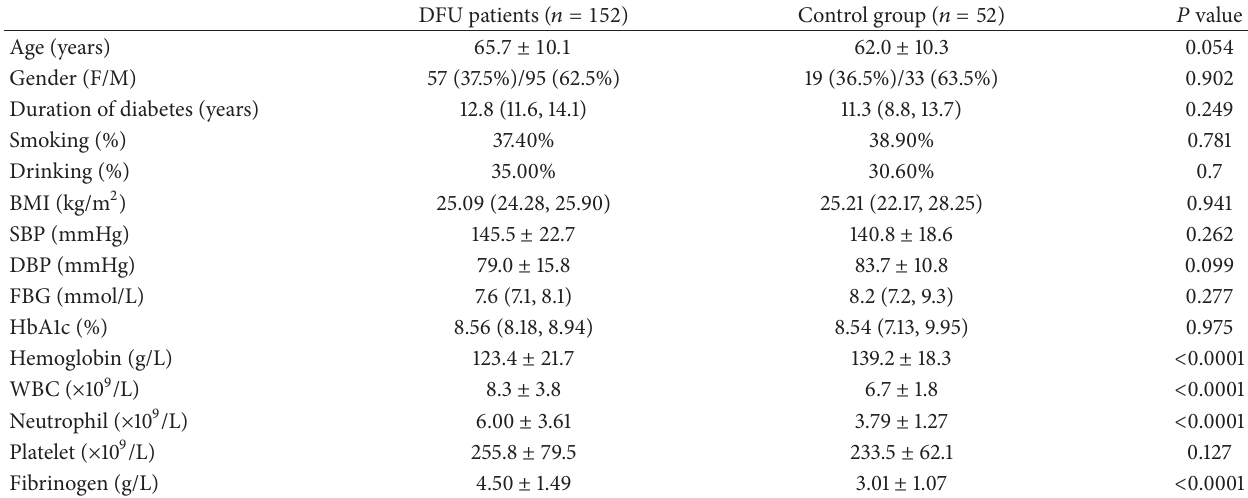
Table 1: Demographic and laboratory features of patients with patients and controls.